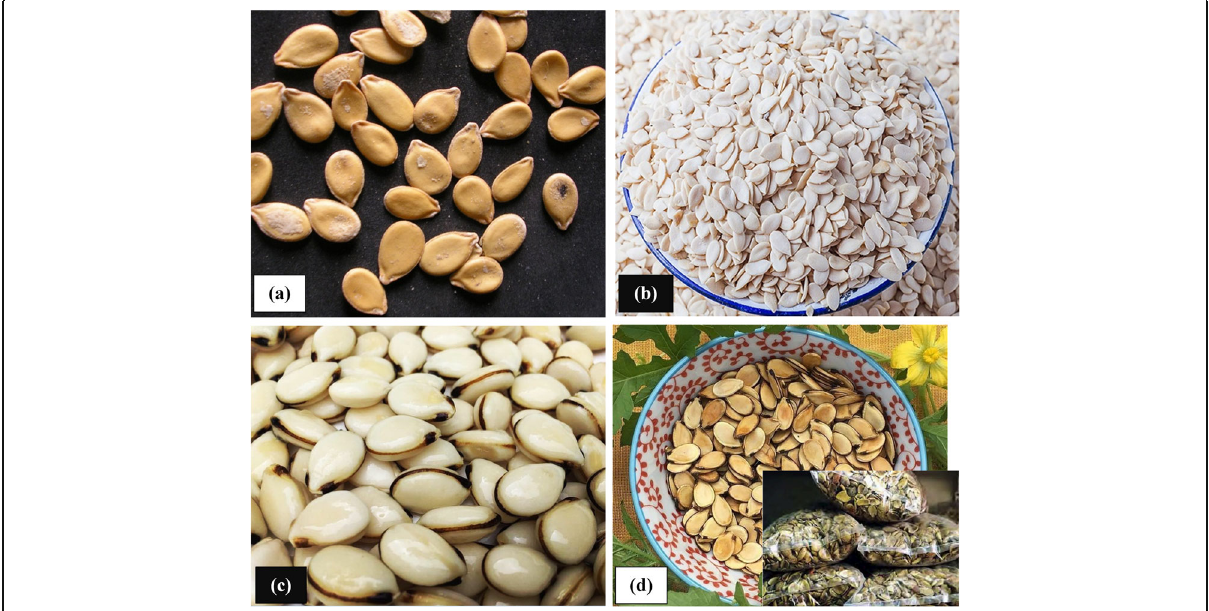
Fig. 2 Distinguishing appearances of the seeds of the two commonly mistaken melon species: a Unshelled Cucumeropsis mannii seeds [11], b Dehulled C. mannii seeds [12], c Wet unshelled Citrullus lanatus seeds, and d Dried unshelled (in plate) [10] and dehulled (in bags) [1] C. lanatus